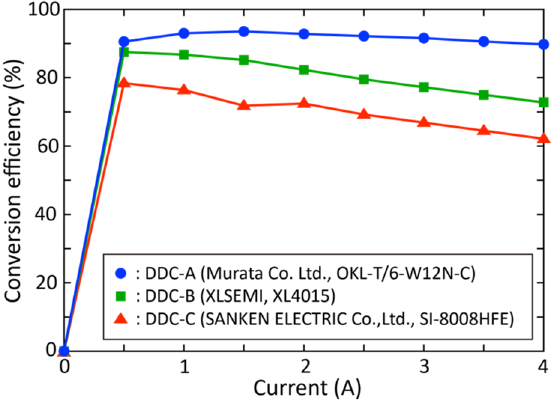
Figure 9. Conversion efficiency of three commercially available DDCs for various currents.